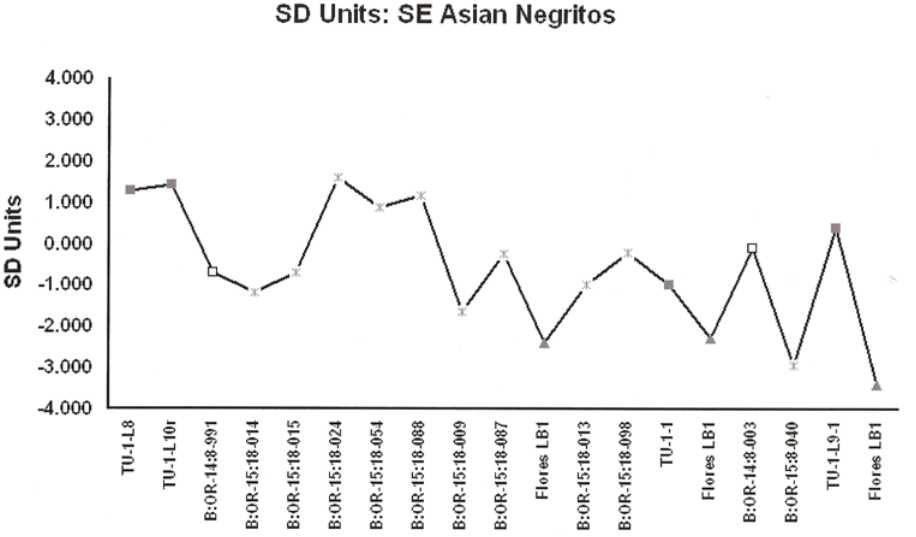
Figure 2. Specimen inventory numbers (see Table 1 for inventory) are from Nelson and Fitzgerald (2006; TU [Chelechol ra Orrak]), Berger et al. (2008; B:OR-14 [Ucheliungs], B:OR-15 [Omedokel]) and Brown et al. (2004; LB1). Chelechol ra Orrak, Grey Squares;